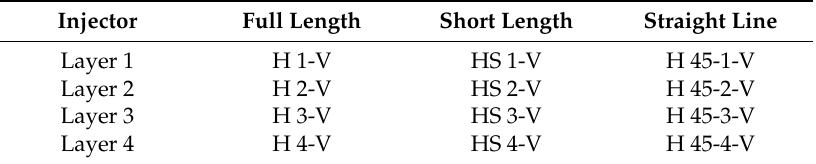
Table 2. Well pattern descriptions of the H-V